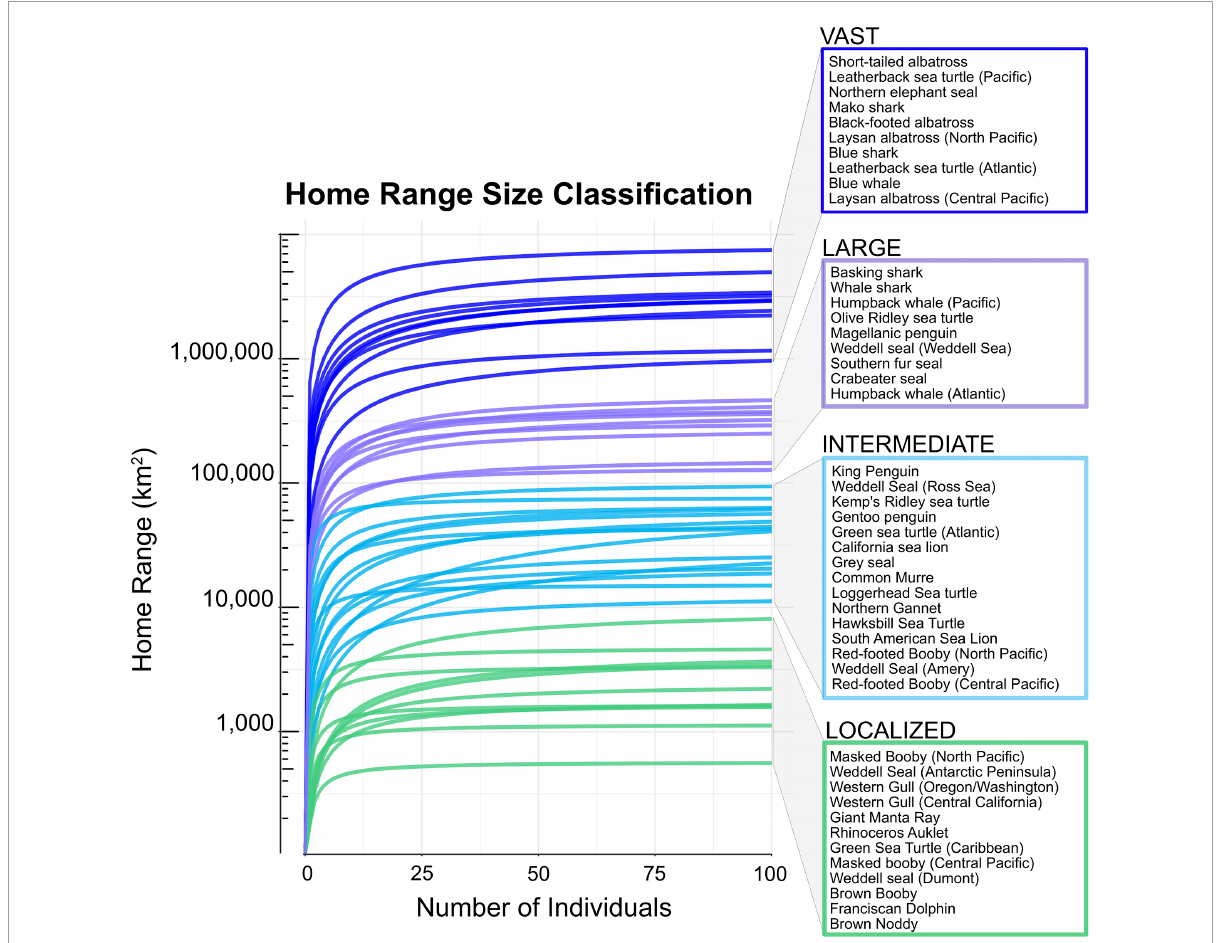
FIGURE 2 Species home ranges (HRs) were classified into one of four home range size-classes based on the asymptotic area of their sampling adequacy curve: ‘ localized ’ (100<HR<10,000), ‘ intermediate ’ (10,000<HR<100,000), ‘ large ’ (100,000<HR<1,000,000), or ‘ vast ’ (HR >1,000,000). Note log scale on the